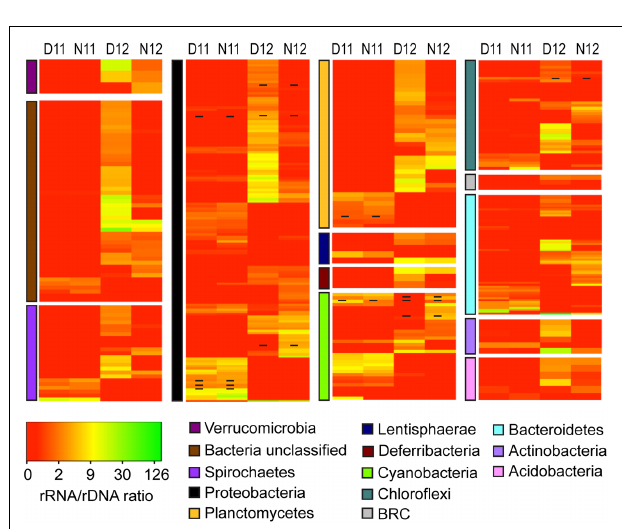
FIGURE 4 | Heatmap analysis of OTU PSP for each bacterial phylum for day and night samples across salinities (D11, Day 2011; N11, Night 2011; D12, Day 2012; N12 Night 2012). The heatmap color represents the extent of PSP as measured by rRNA:rDNA ratio within each OTU. Square colors shifted toward brighter green indicate higher PSP of that OTU. Dash within squares indicates abundant OTUs. Standard deviations are located in Supplemental Table S3.